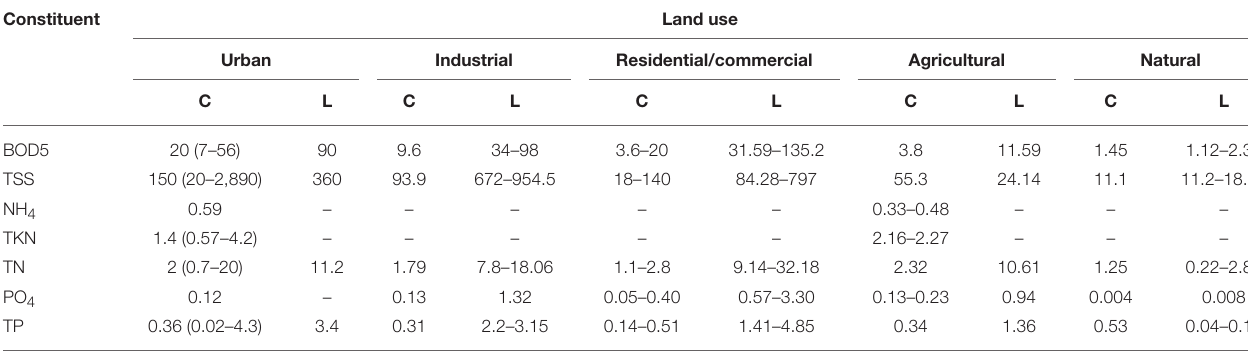
TABLE 1 | Constituents of storm waters from areas differing in their predominant land use.